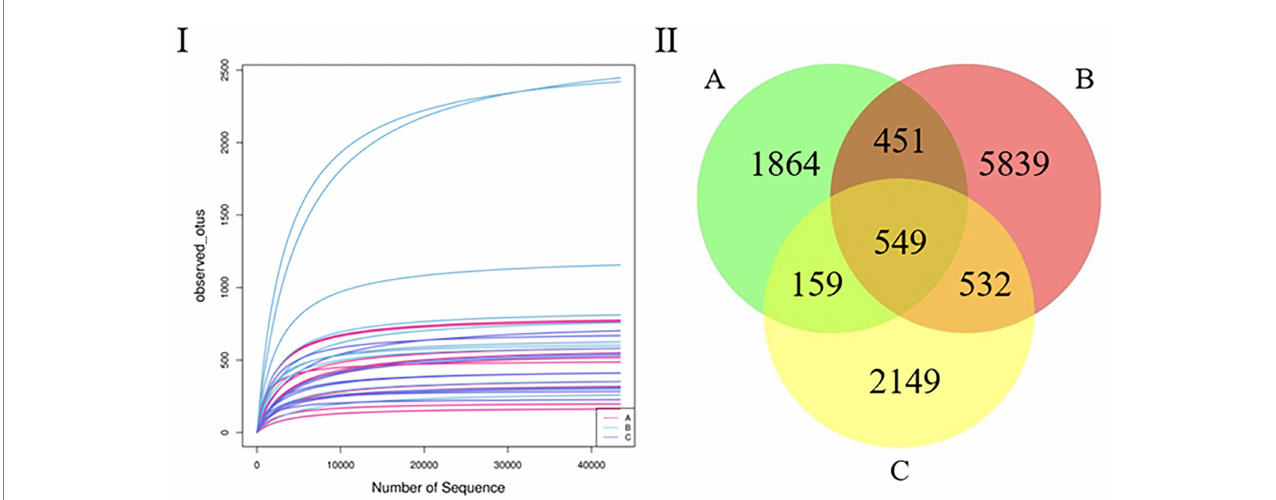
FIGURE 1 (I) Rarefaction curve. Curves of assorted colors show the observed OTUs (vertical axis) of each sample at a different number of sequences sampled (lateral axis). Flat curves indicate that sequencing depth is sufficient to reflect most of the microbial data in the samples. (II) Venn diagram. OTU distribution in the three groups.